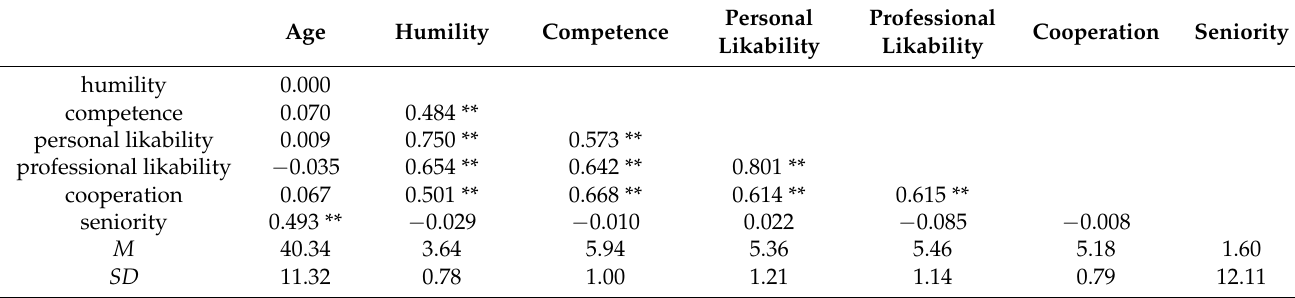
Table 2. Correlation Coefficient Among